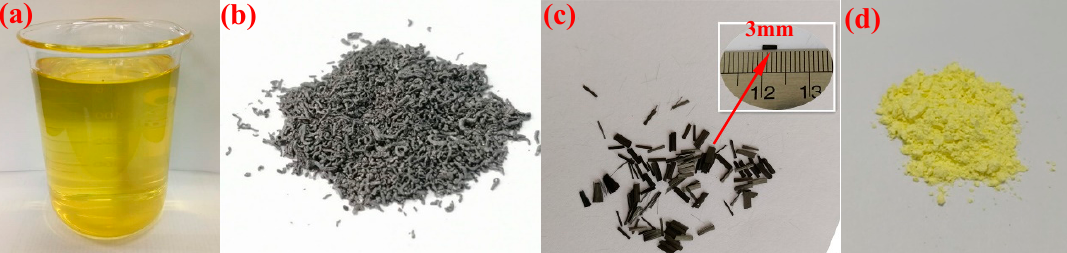
Figure 1. The morphology of the raw materials: ( a ) Paraffin; ( b ) EG (Expanded Graphite); ( c ) carbon fiber; ( d ) gypsum.